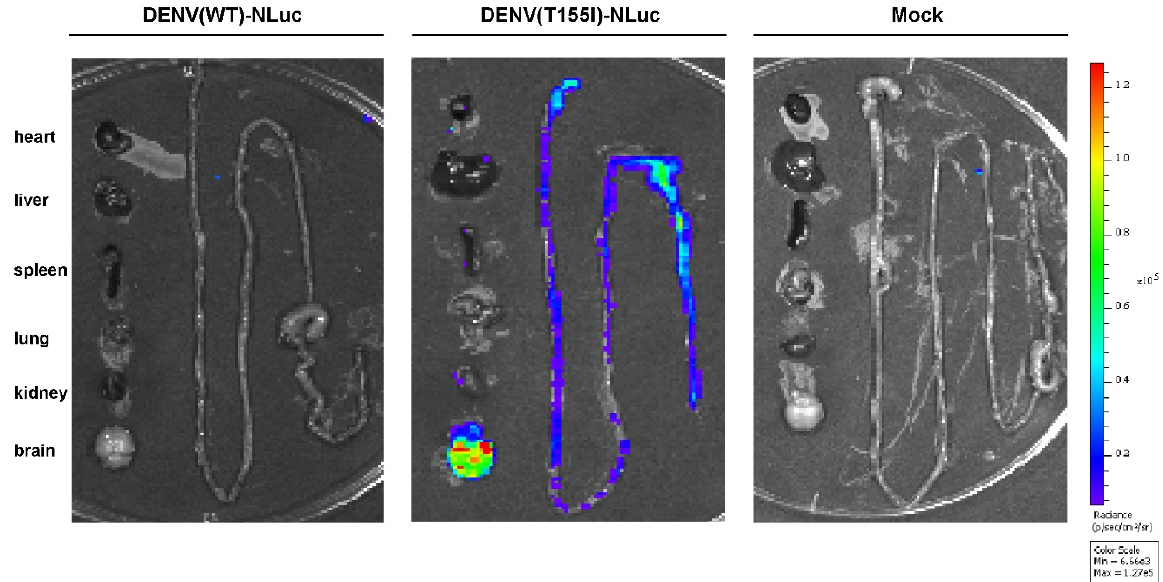
Figure 5. Fluorescence of tissues from major organs of mice on day 7 after intracerebral infection. BALB/c mice (n = 3) were injected intracerebrally with a dose of 4.4 lg PFU of virus, and heart, liver, spleen, lung, kidney, brain, and intestinal tissues were dissected for fluorescence detection at 7 DAI. Independent experiments were performed twice. Representative animal tissues from organs of each group are shown.